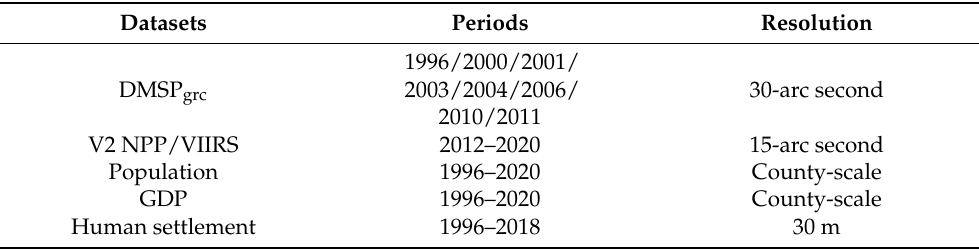
Table 1. Datasets and description.